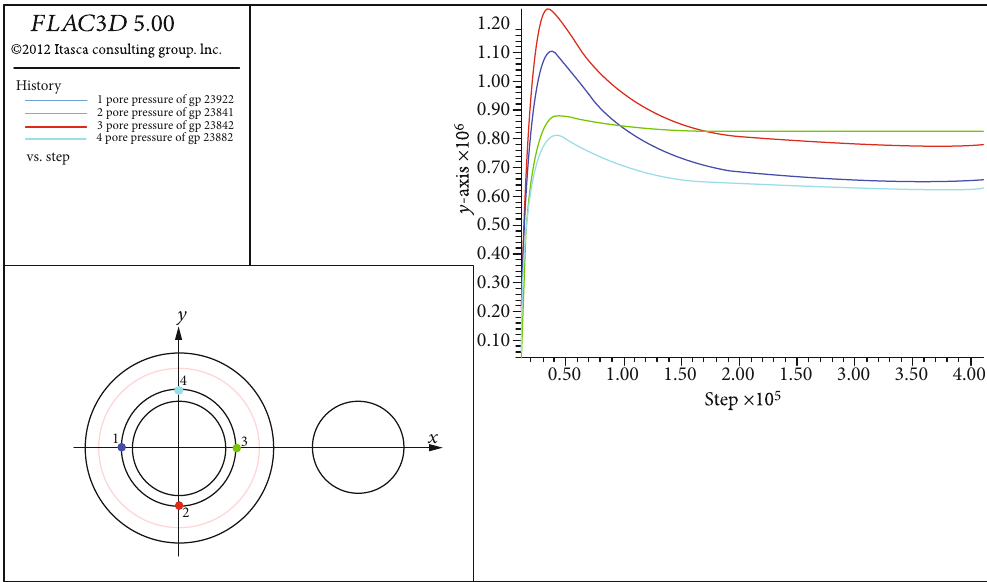
Figure 4: Pore water pressure of recorded points.